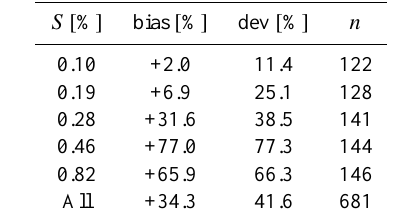
Table 6. Characteristic deviations between hygroscopicity param- eters determined by CCN measurements ( κ a ) and predicted on the basis of organic and inorganic mass fractions determined by inte- gral AMS measurements ( κ p ): arithmetic mean values of the rel- ative bias ( 1 bias κ =( κ p − κ a )/ κ a ) and of the total relative deviation ( 1 dev κ = | κ p − κ a | / κ a ). n is the number of data points. S [ % ] bias [ %